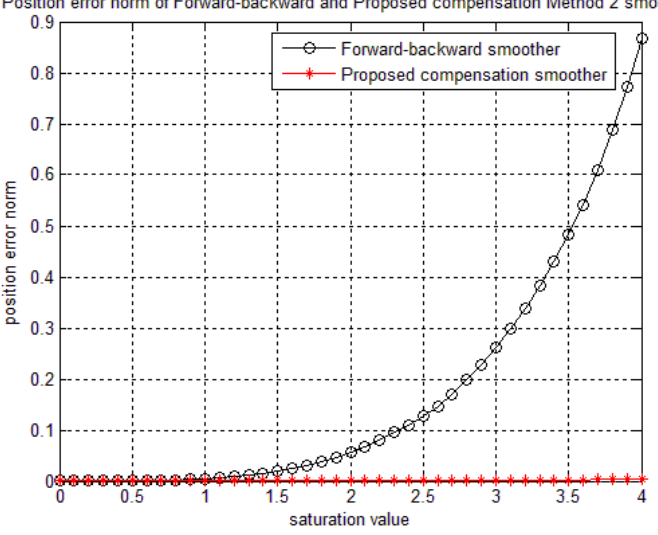
Figure 11. The effect